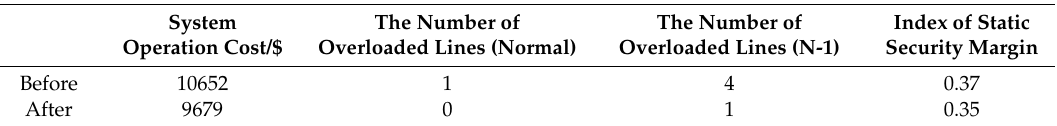
Table 6. The comparison of system economic efficiency and static security index before and after optimization in Case A.